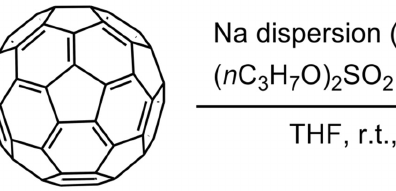
Figure 2. DART-MS (positive) of the obtained mixture of C 60 ( n C 3 H 7 ) n .